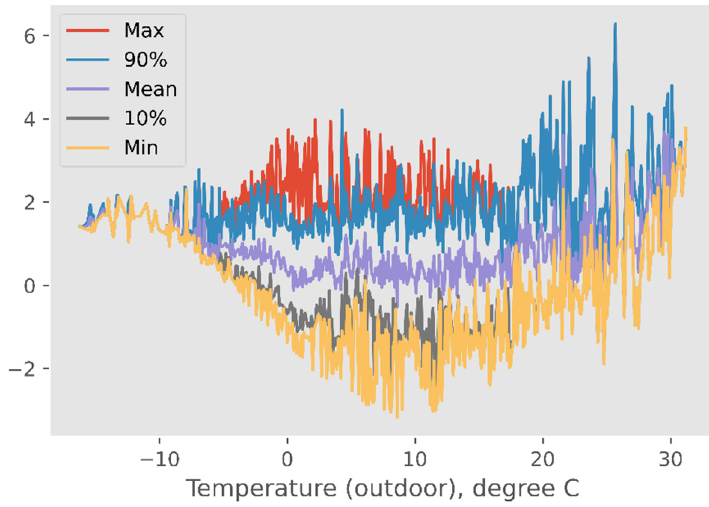
Figure 11. Average moisture excess in Krimulda church on the balcony.